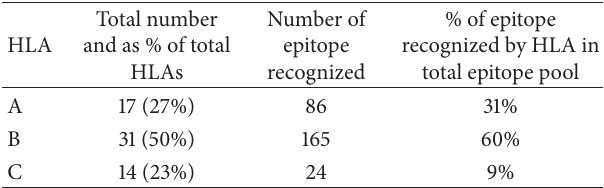
Table 5: Analysis of the different HLA alleles.